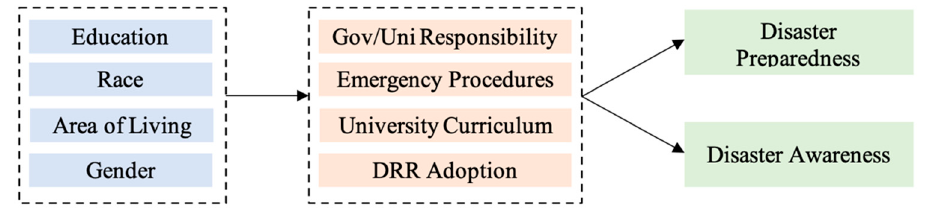
Figure 4. Expected Conceptual Model Before the Analysis.